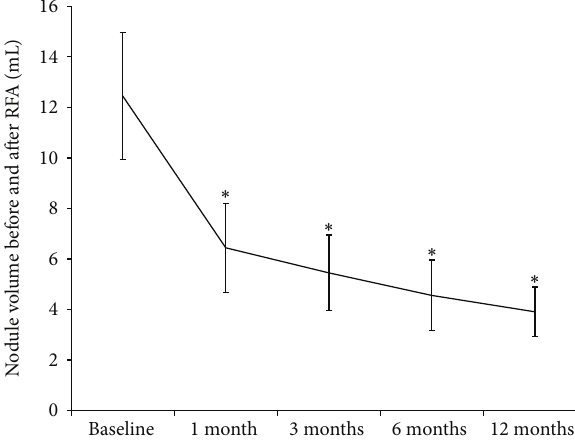
Figure 3: Volume (mL) reduction at 1, 3, 6, and 12 months after RFA. Data are expressed as mean ± SEM. ∗ 𝑃 < 0.05 versus